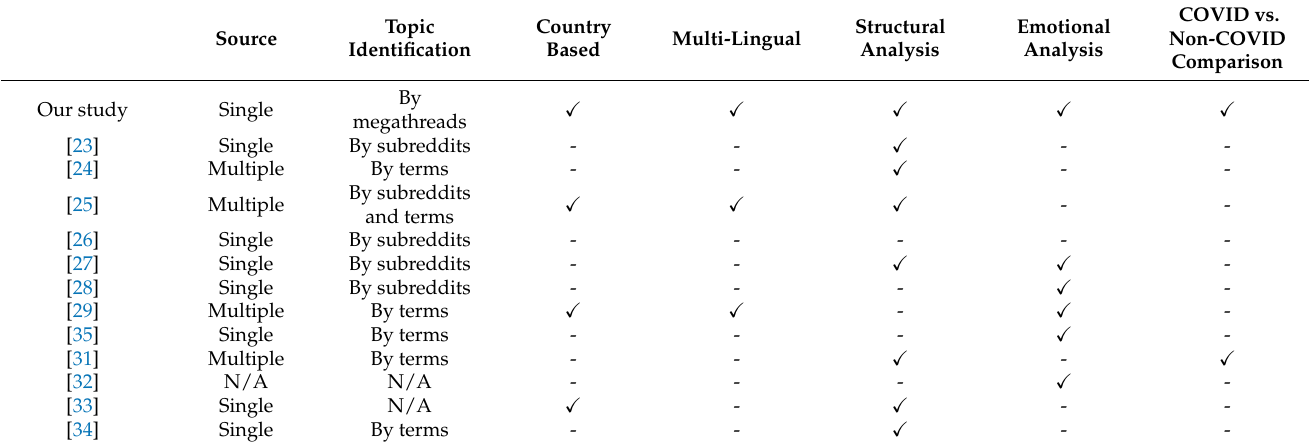
Table 1. Comparison properties overview of our study and most related ones; cells with N/A indicate absence of that corresponding property.